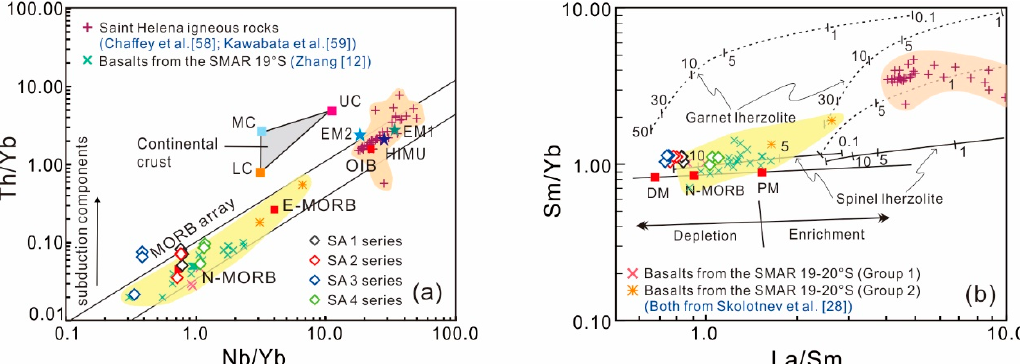
Figure 11. Plots of the SMAR basalt samples: ( a ) Nb/Yb versus Th/Yb, after [91] and references therein; ( b ) La/Sm versus Sm/Yb, after [92] and references therein. MORB: mid-ocean ridge basalt; N-MORB: normal mid-ocean ridge basalt; E-MORB: enriched mid-ocean ridge basalt; OIB: ocean island basalt. DM: depleted mantle; PM: primitive mantle; LC: lower crust; UC: upper crust; MC: middle crust. Data for basalts from the SMAR 19°–20°S are from [12,28]. Data for igneous rocks from the Saint Helena islands are from [58,59].